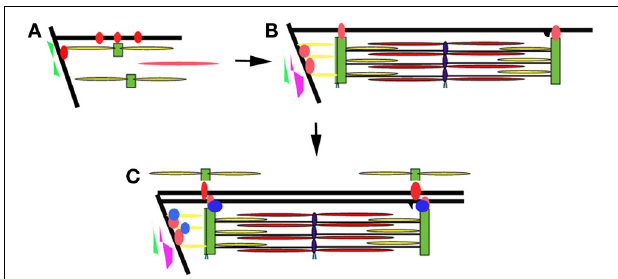
FIGURE 7 | Model of myofibril assembly and myocyte organization. (A) The first myofibrils form at the insertion of actin filaments (yellow rods) and myosinfilaments(redrod)attheterminalendsofthemyocytealongthelateral sarcolemma. Integrins (red circles) are initially diffusely organized along the sarcolemma before concentrating at sites of actin insertion sites (terminal ends of the myofibril and overlying the Z disks of the superficial myofibrils) wheretheyhelporganizethesurroundingECMincludingfibronectin(ingreen). (B) As myofibrillogenesis proceeds, integrins become more concentrated at contact sites and laminin (purple) is deposited along the somite border. Sarcolemmal invaginations that will eventually become the T tubular network form overlying the Z disks (black projection). (C) Additional adhesion complex proteins (blue) are recruited to stabilize and strengthen the contacts at the terminal ends of the myofibril. The patterning of the sarcolemma and the surrounding ECM results in the patterning of the sarcolemma and subsequently the newly assembling myofibrils of neighboring